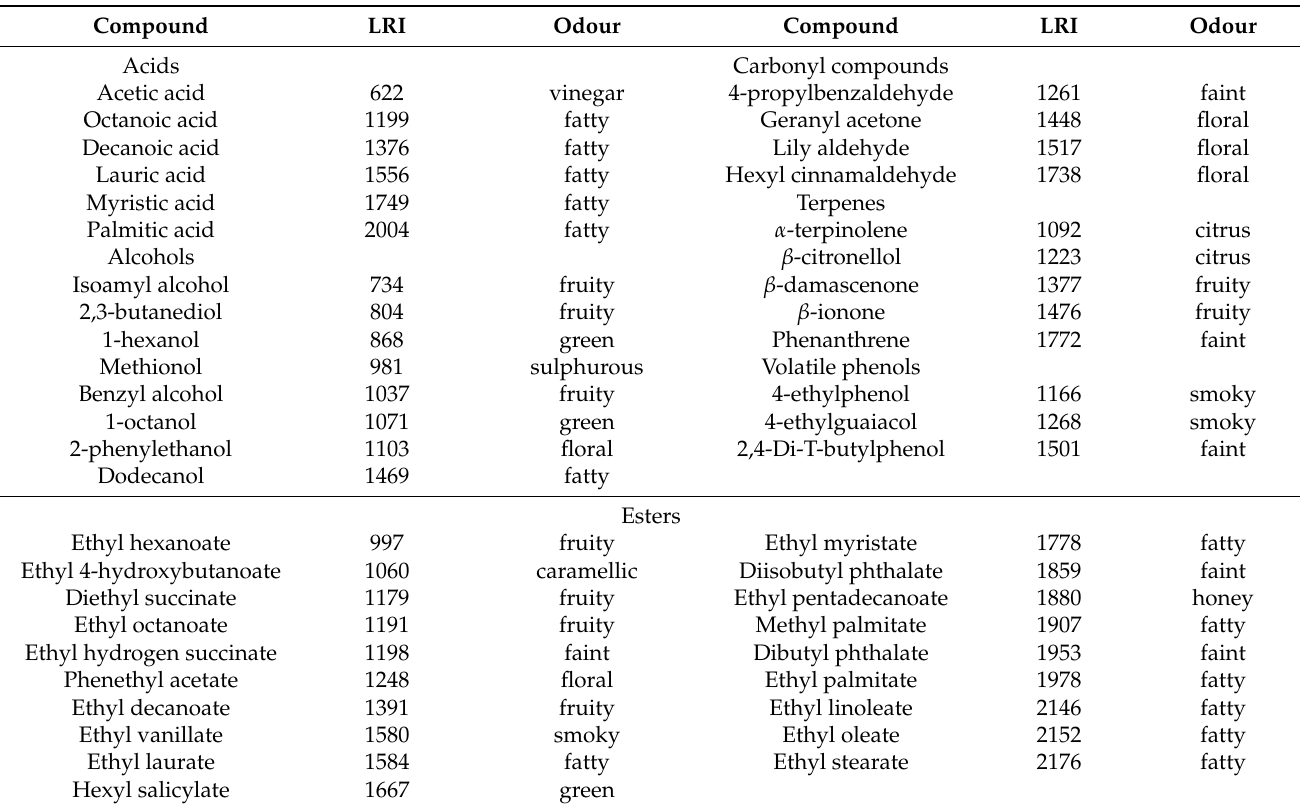
Table 2. Volatile compounds, their linear retention indices (LRI) and odour description in conventional and ecological Cabernet Sauvignon red wine and retentates obtained by nanofiltration at 2.5, 3.5, 4.5 and 5.5 MPa with and without cooling.